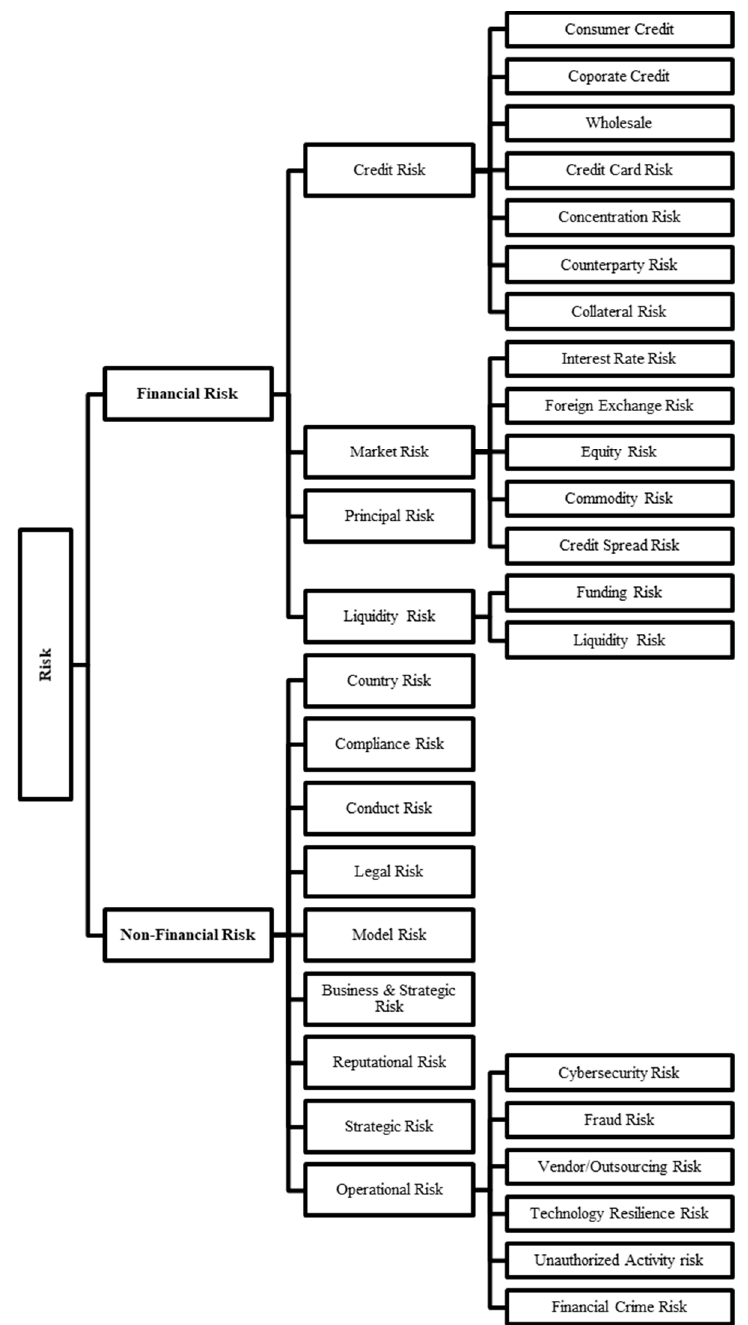
Figure 1. Taxonomy of risks.